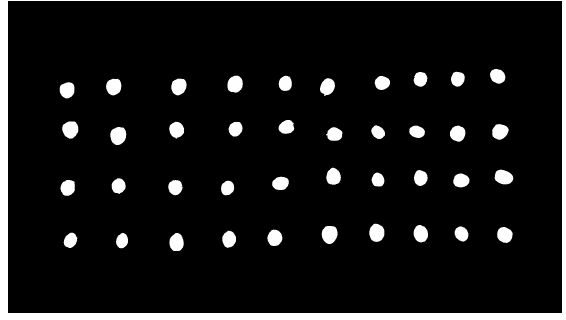
Figure 3. Result of the segmentation of the image of the A1 set, originally shown in Figure 1.